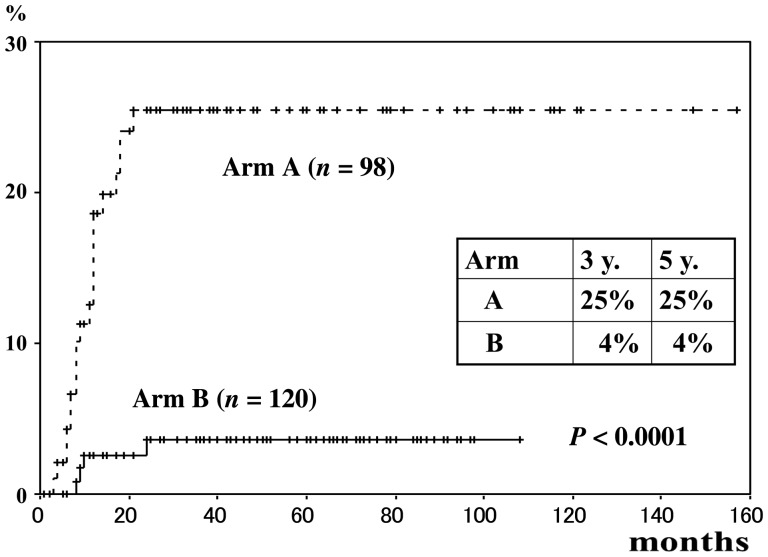
Cumulative rectal complication rate by treatment schedule (June 1998–December 2009).